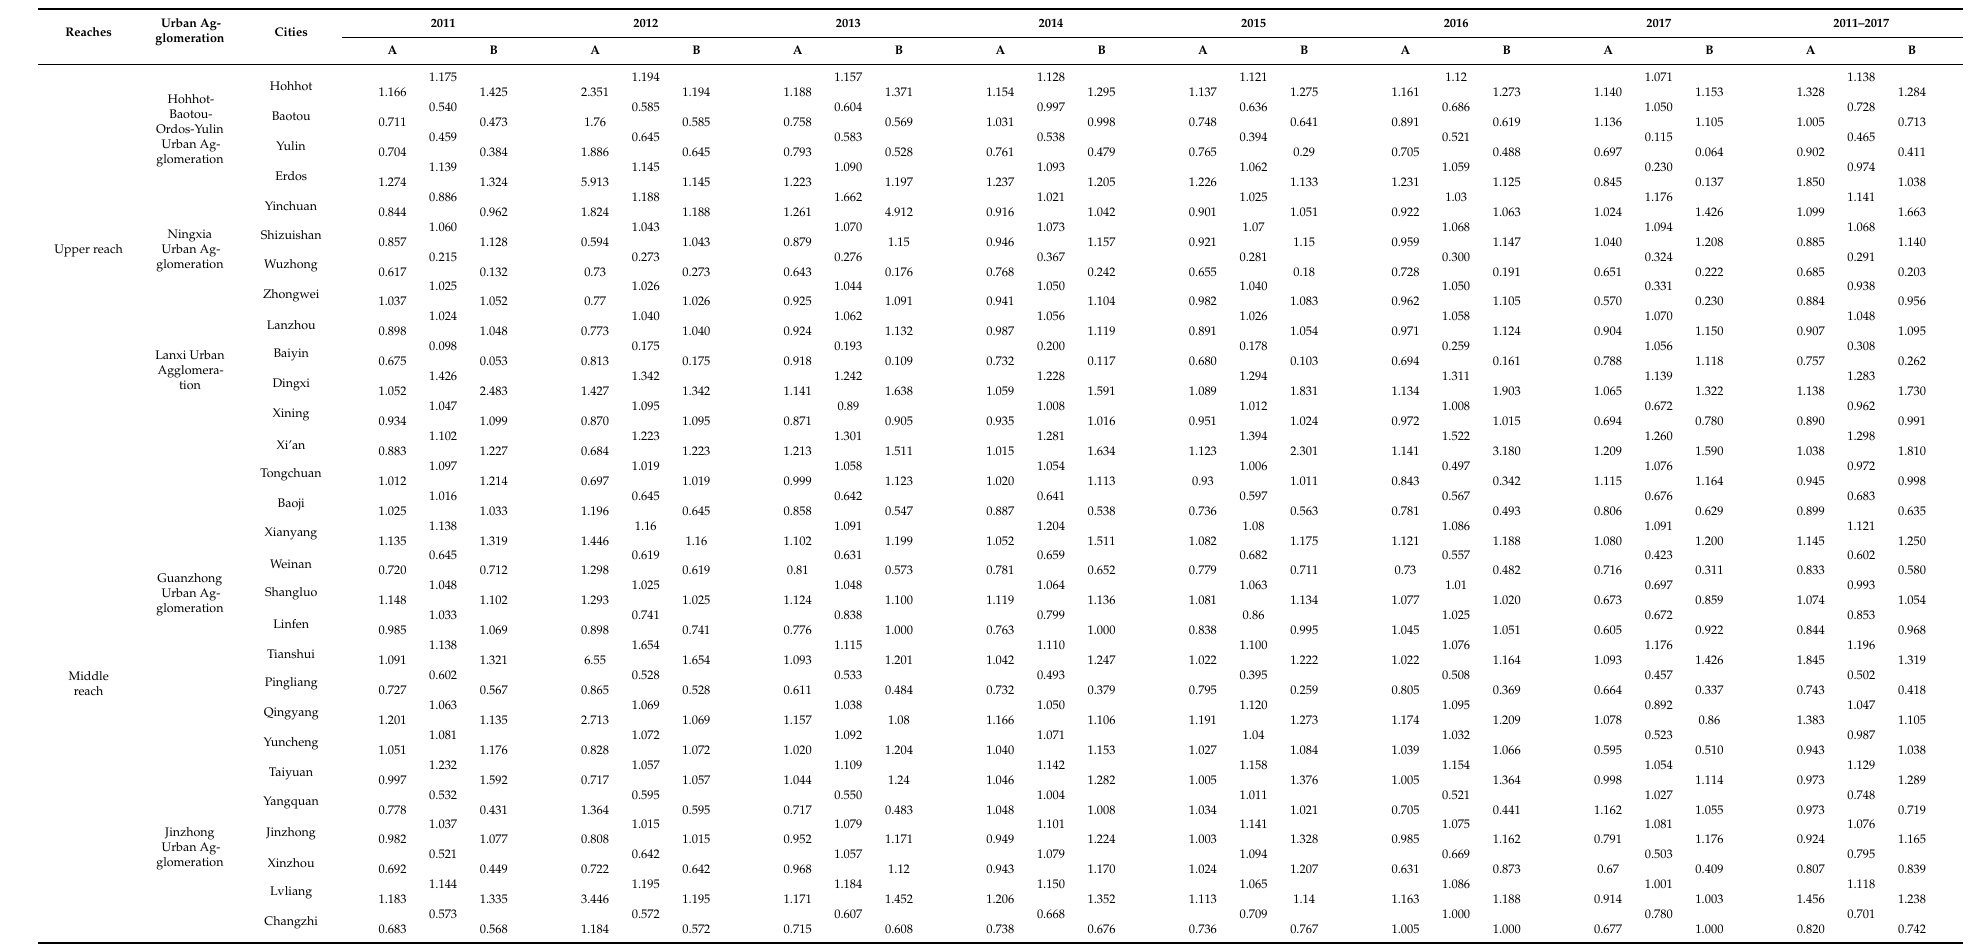
Table A3. A two-stage evaluation of the EWP of urban agglomeration in the Yellow River Basin from 2011 to